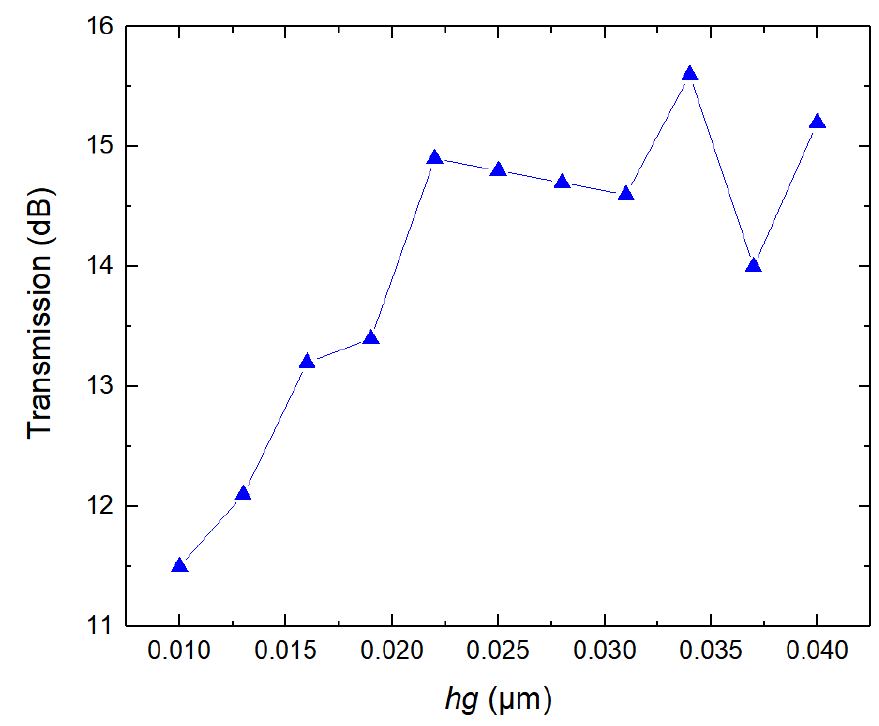
Figure 7. Transmission under different grating depths.